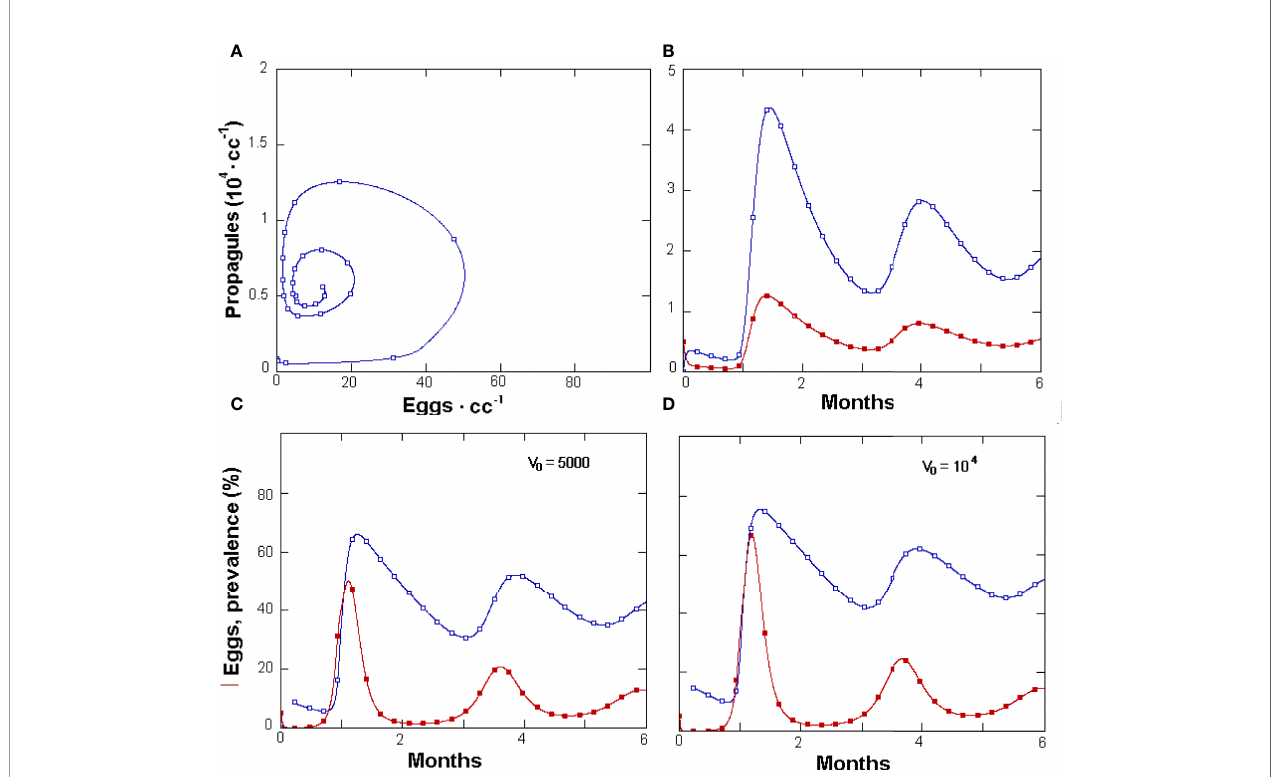
FIGURE 4 | (A, C) Phases space relationship between Pochonia chlamydosporia parasitic propagules and Meloidogyne incognita eggs (A) and related density changes in 6 months in a GPNRd-simulated rhizosphere microcosm. (B) Six-month population dynamics of parasitic ( fi lled squares) or non-parasitic fungus propagules. Data produced by GNPRd at different initial parasitic propagule densities (C, D) (for initial variables and constants see Table 1 ).